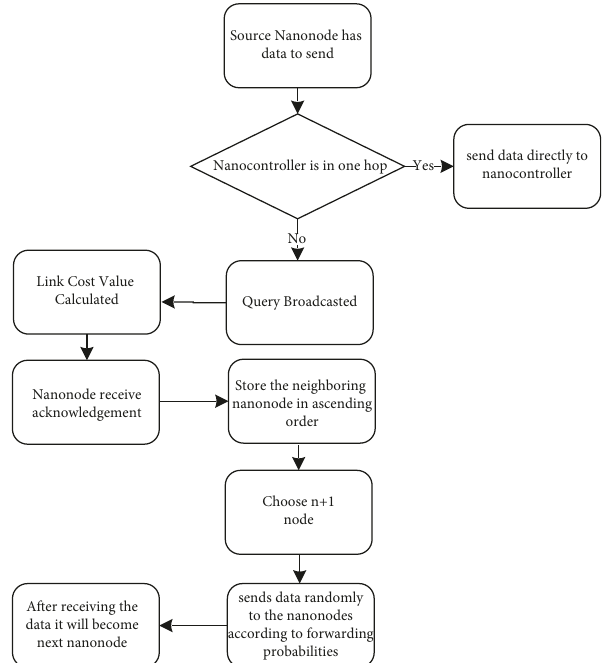
Figure 2: Process of EEMR